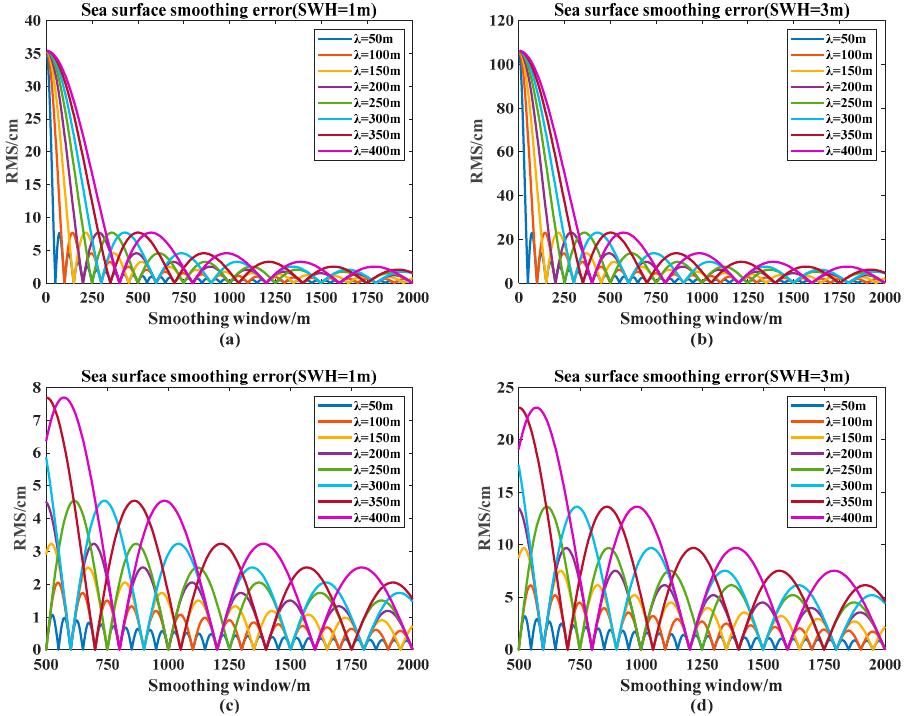
Figure 7. E ff ect of smoothing window on monochromatic waves of di ff erent wavelengths (in cm). The SWH is selected as 1 m ( a ) and 3 m ( b ), the wave direction is 0 ◦ and the pixel size is 5 m × 5 m. The smoothing window is a square window. ( c , d ) are the magnification of the smooth window results from 500 m to 2000 m in ( a ) and ( b ),